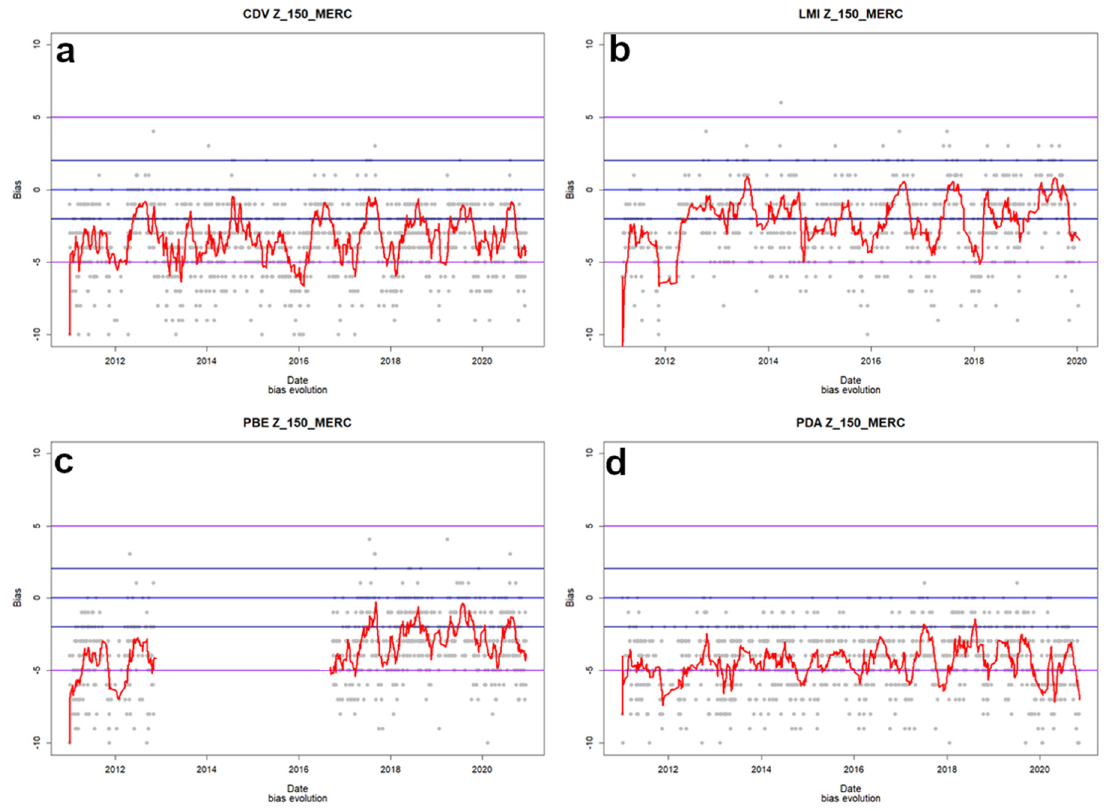
Figure 3. Bias estimation for a simple QPE of the 4 radars (( a ) CDV, ( b ) LMI, ( c ) PBE, and ( d ) PDA) for the 2011–2020 period.